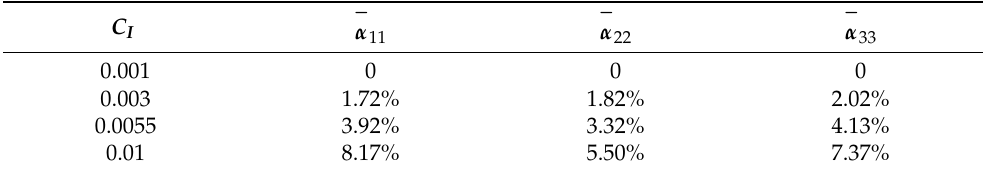
Table 7. PRDs of computed mean coefficients of thermal expansion of 13 wt.%. CF/ABS de- posited bead.